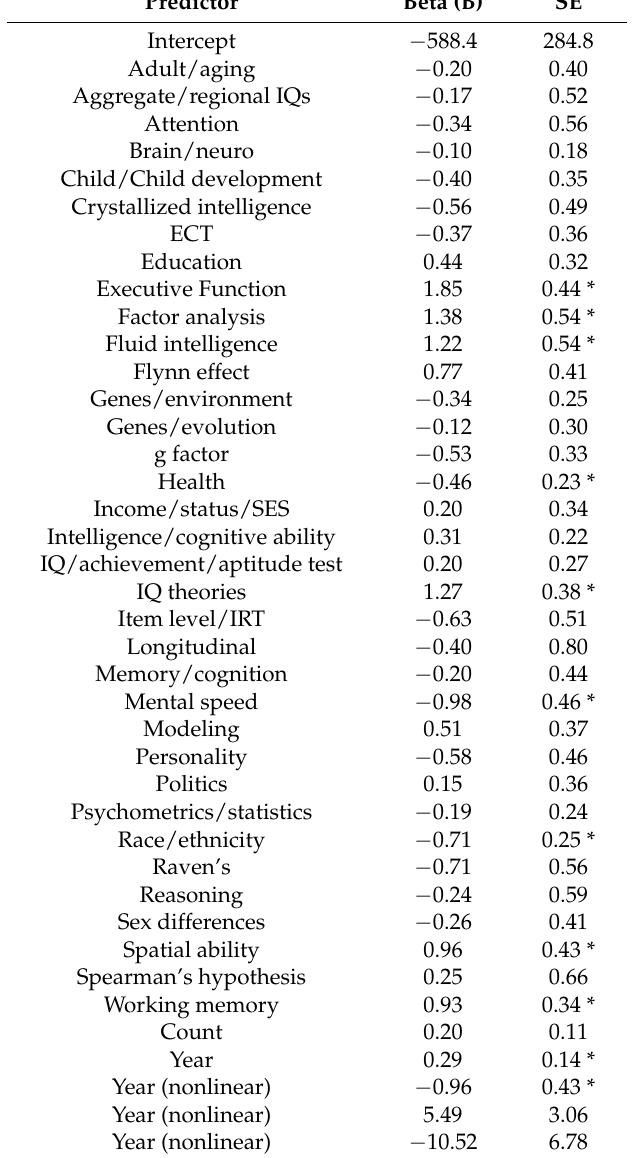
Table 3. Regression results for citations by keyword